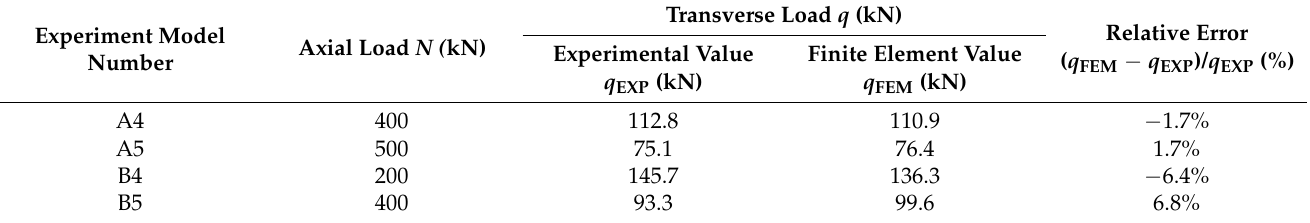
Table 3. Comparison of bearing capacity between finite element simulations and